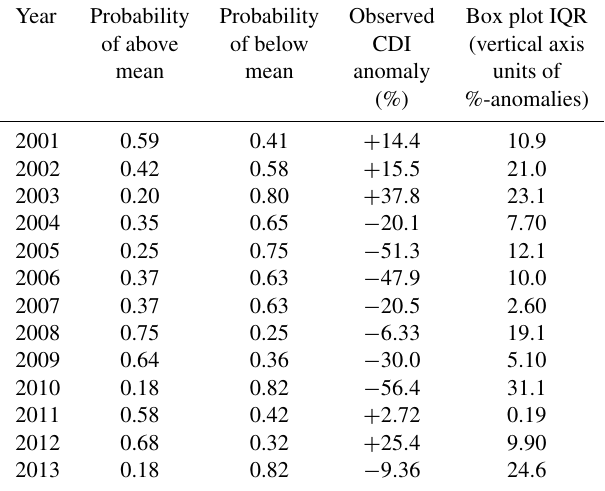
Table 1. The table below shows important statistics calculated from k -NN forecasts of CDI. In particular, column 2 displays the prob- abilities of the CDI for a particular season being above the CDI climatology. These probabilities are calculated from the k -NN sam- pling distribution, which in turn is simulated from historical values of the CDI based on the nearest neighbors determined in the pre- dictor variable space. Column 3 shows the complementary prob- abilities of values being below this historical average. The fore- casts for years 2001–2013 are retrospective and may serve as cross- validation for the k -NN model. Column 4 shows the values of the actual (observed) CDI anomalies with respect to the 1901–2013 cli- matology as percentages. A negative value implies that the actual CDI value was below the historical average by the given percent- age. The rounded IQR values are shown in the final column of the